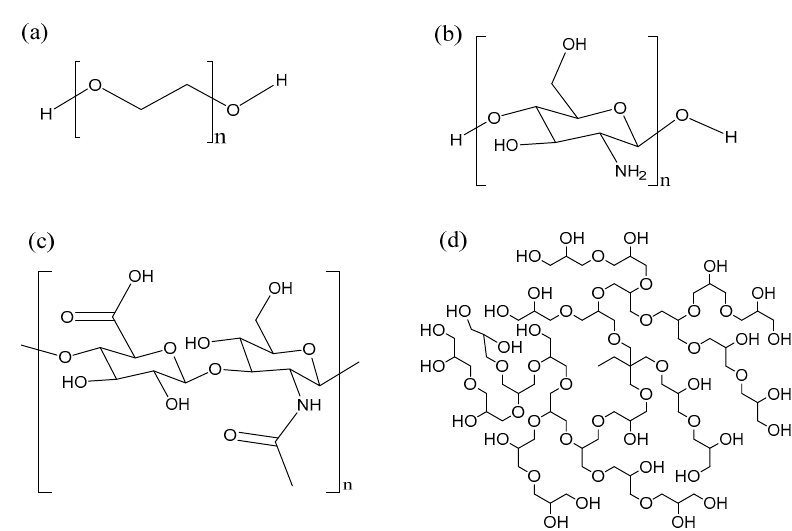
Figure 8. Various polymers used for AMP conjugation: ( a ) polyethylene glycol (PEG), ( b ) chitosan, ( c ) hyaluronic acid, ( d ) hyperbranched polyglycerol (HPG).